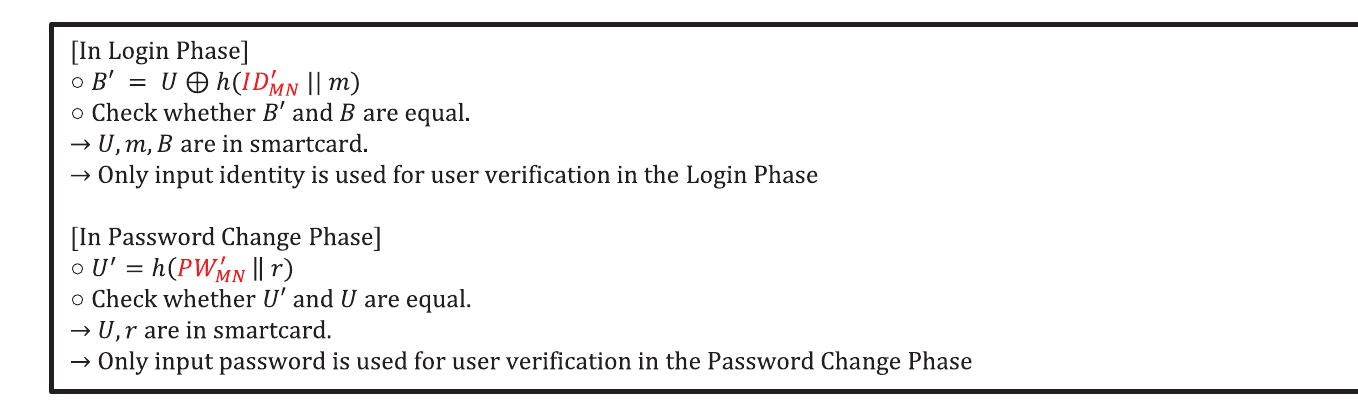
Fig 4. Incomplete verification of identity and password in Ahmed et al.’s